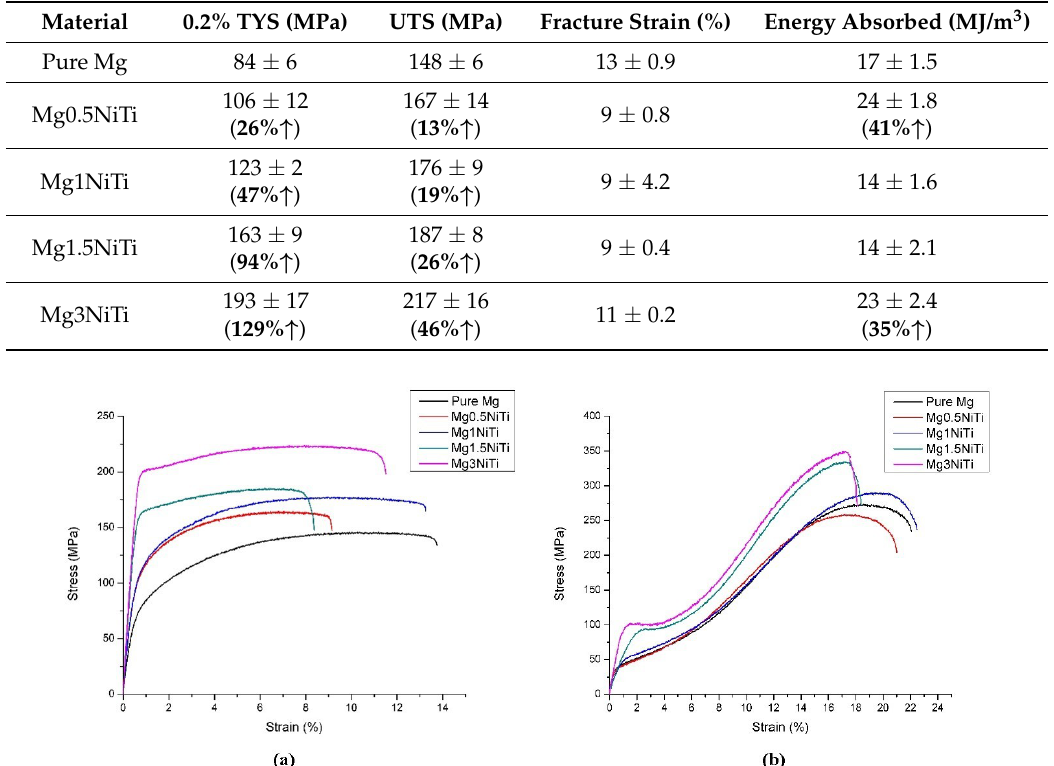
Table 3. Room temperature tensile testing results.